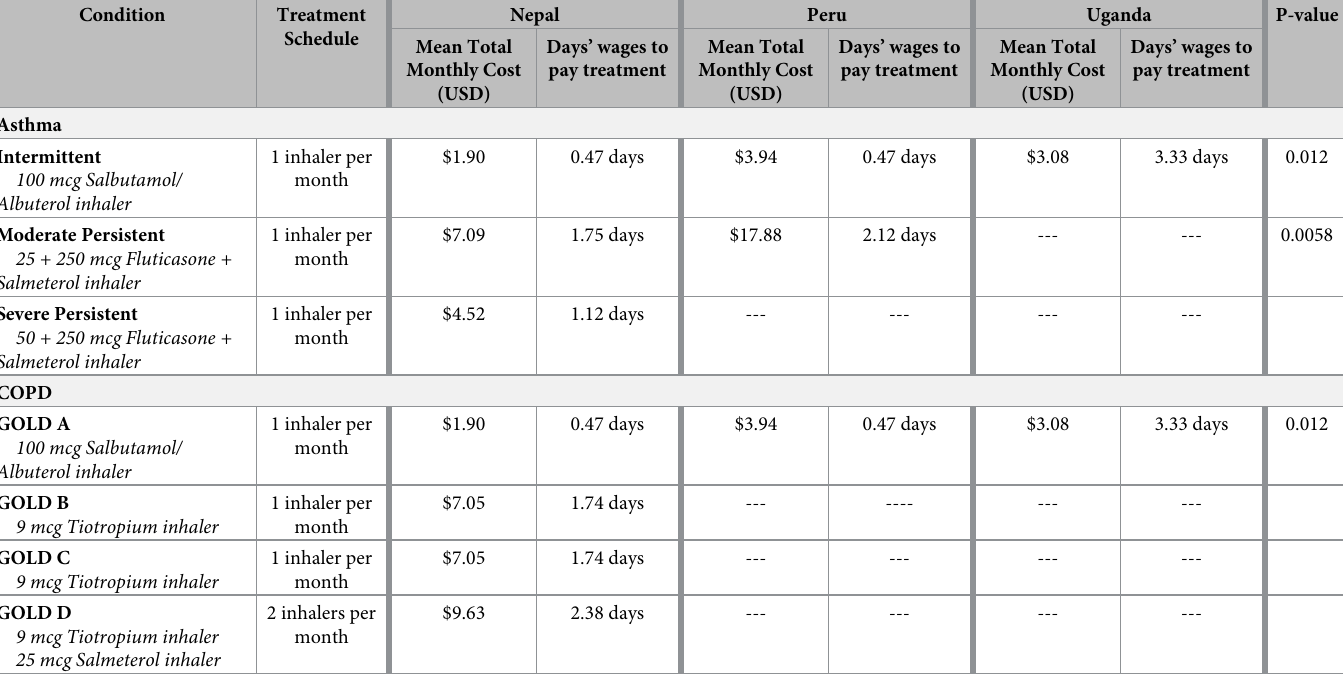
Table 2. Affordability of selected medicines to treat asthma and COPD based on mean total monthly cost and number of days’ wages needed for a minimum wage government worker.